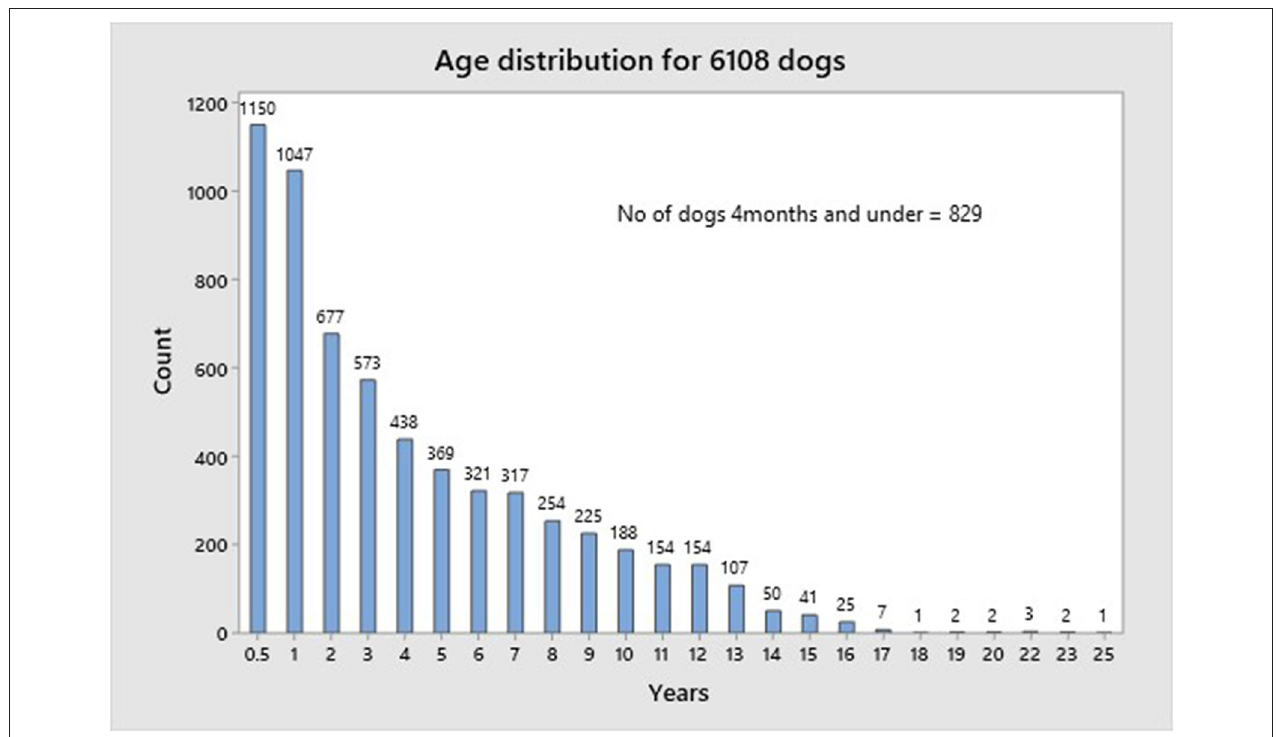
FIGURE 4 | The age distribution of all